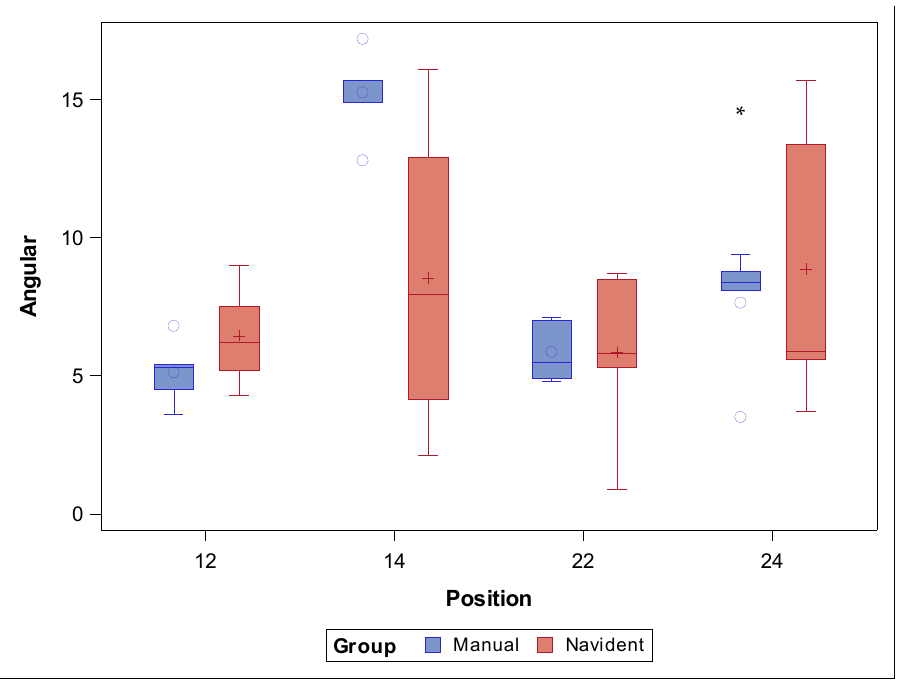
Figure 7. Box plot of angular deviations found in the study groups and ZI positions. Median values are represented by the horizontal lines within each box. The symbols represent extreme values.